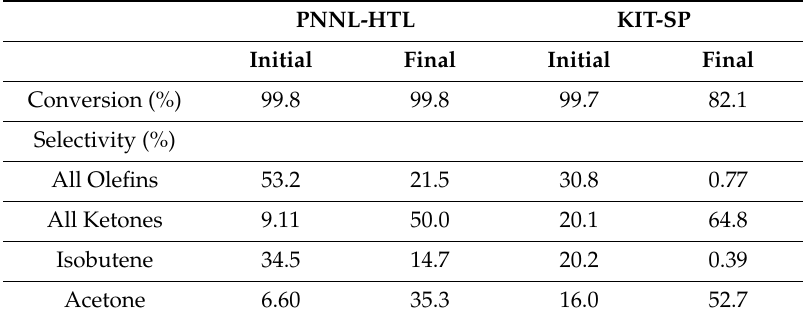
Figure 4. High GHSV stability of ( A ) PNNL-HTL feedstock, S / C = 2.8, and ( B ) KIT-SP feedstock, S / C = 4.7. Temperature: 450 ◦ C, GHSV: 5500 h − 1 , catalyst loading 0.7 g, N 2 50 vol%. Table 2. Comparison of initial and final activity and selectivity of PNNL-HTL and KIT-SP feedstocks shown in Figure 4.